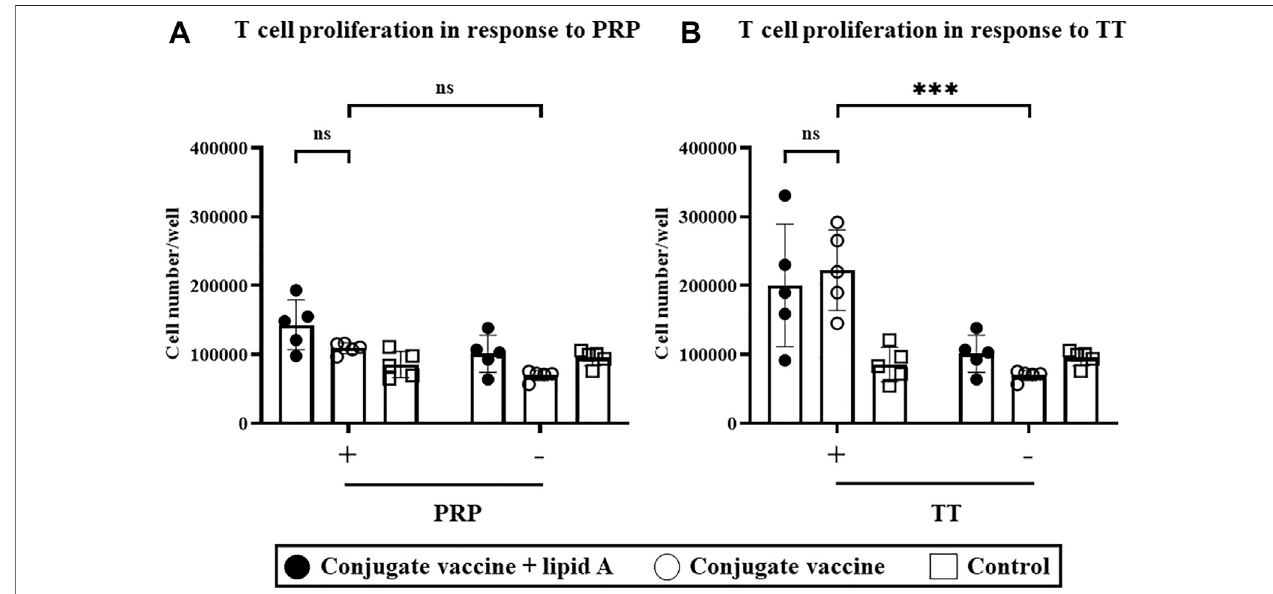
FIGURE 4 | Alcaligenes lipid A has no effect on the TT-speci fi c T-cellresponse. Mice were immunized subcutaneouslywith Haemophilus B conjugate vaccine withor without 1 μ g of Alcaligenes lipid A; control mice were immunized with PBS. Splenic CD4 + cells were collected 1 week after the fi nal immunization and stimulated with (+) or without( – ) (A) 2.08 μ g/mlPRPor (B) 5 μ g/mLTT.Afterstimulationfor4 days,liveCD4 + cellswerecounted.Dataarerepresentativeoftwoindependentexperimentsandare presented as mean ± 1 SD. ( n (cid:2) 5/group), and statistical signi fi cance was evaluated by using one-way ANOVA (ns, not signi fi cant; ***, p <